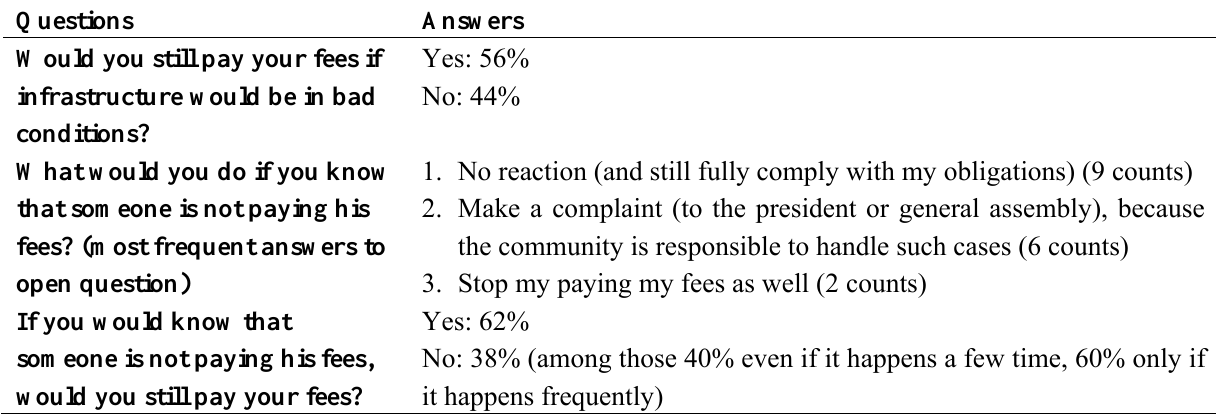
Table 5. Analysis of questions on cooperative behavior.